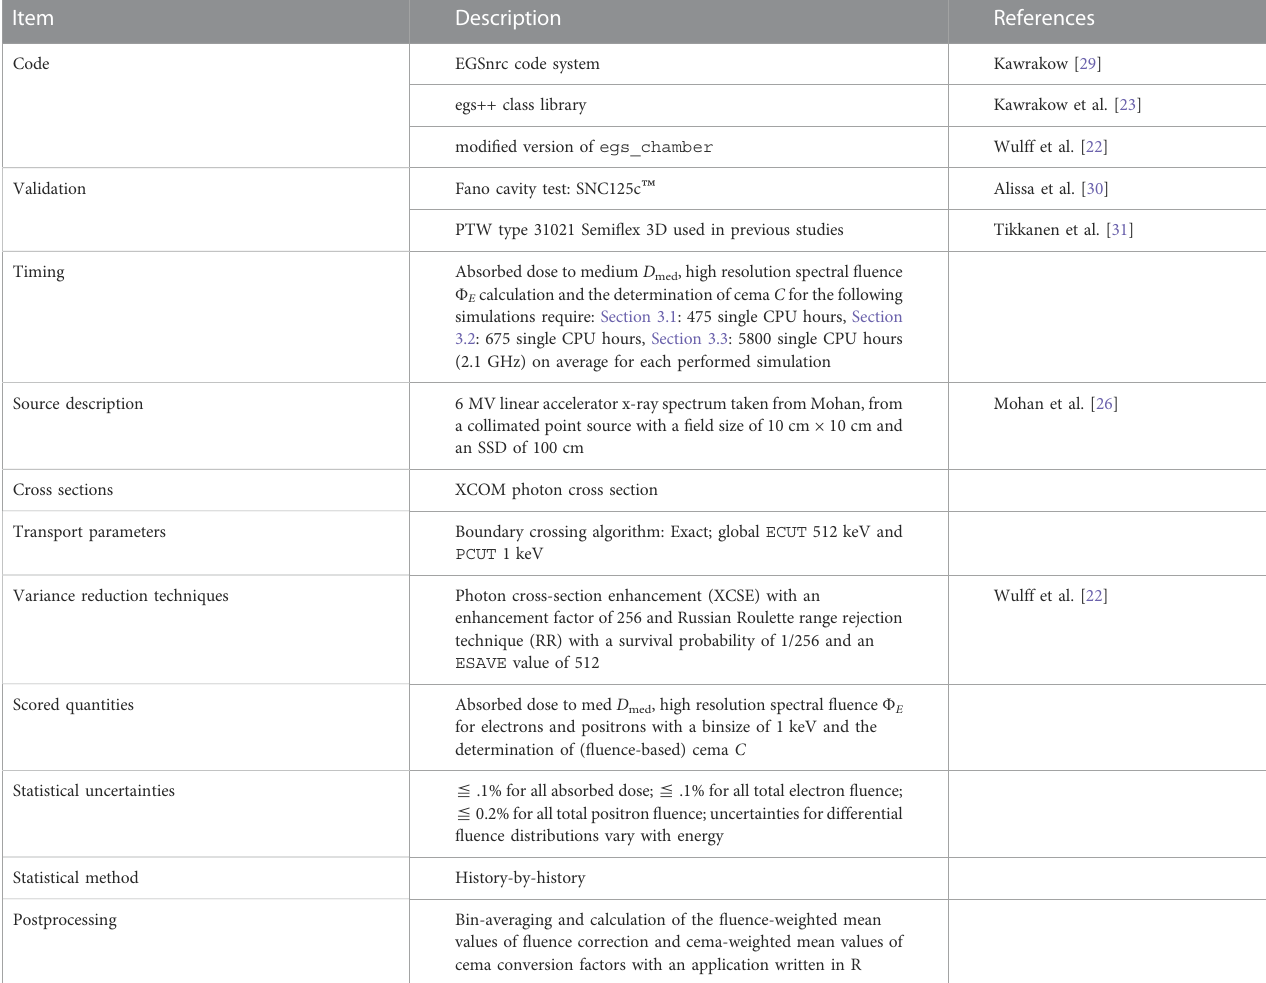
TABLE 1 Summary of simulation properties and parameters with EGSnrc, according to the recommendations of AAPM